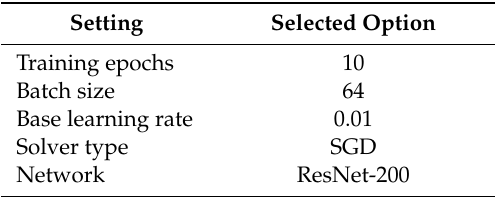
Table 2. The settings of the Image Classification